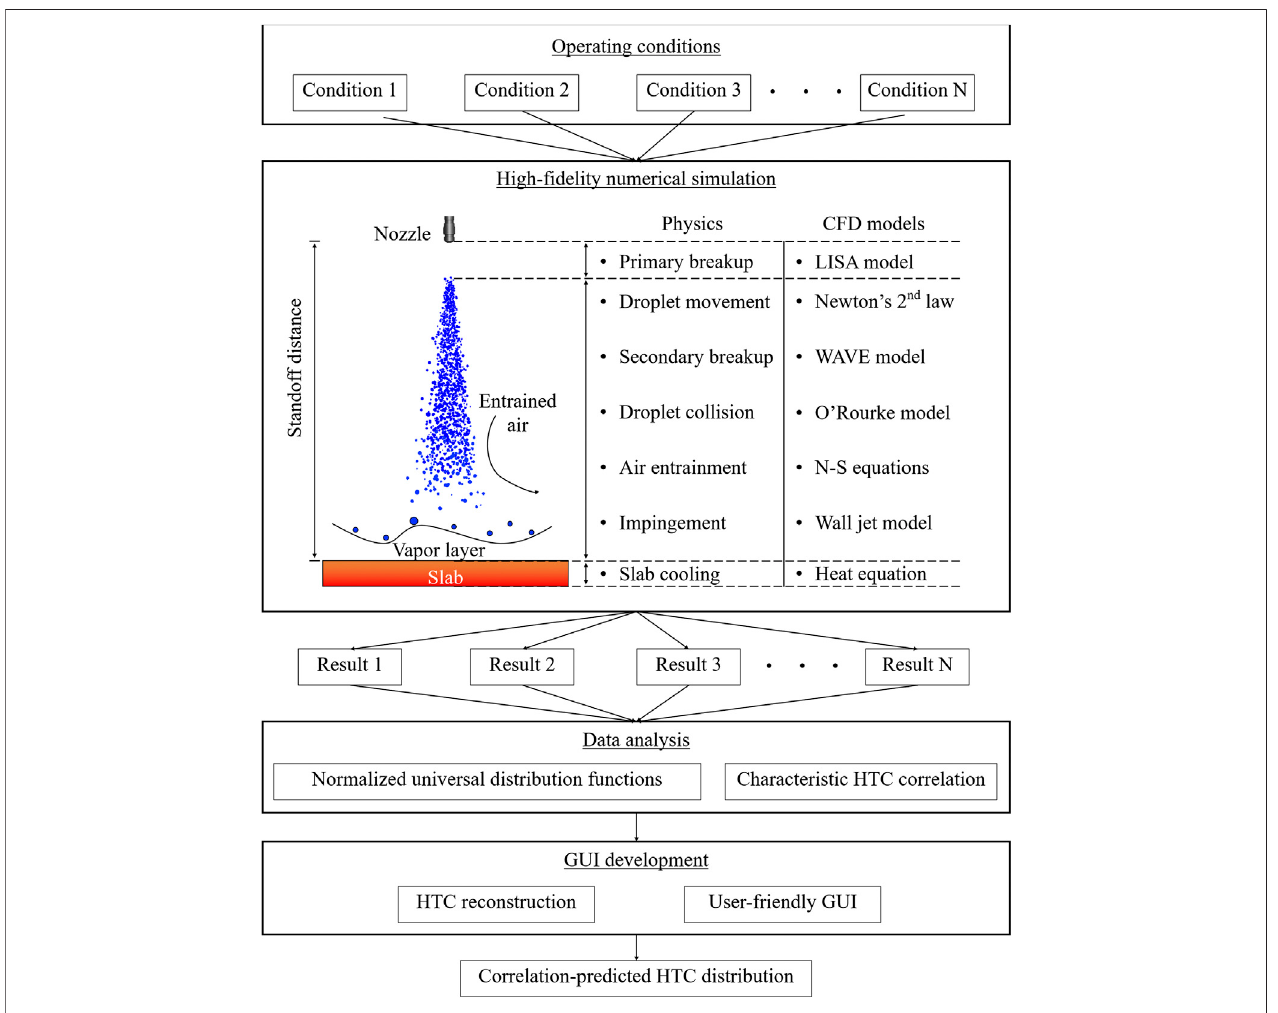
FIGURE 2 | CFD-based development process of HTC